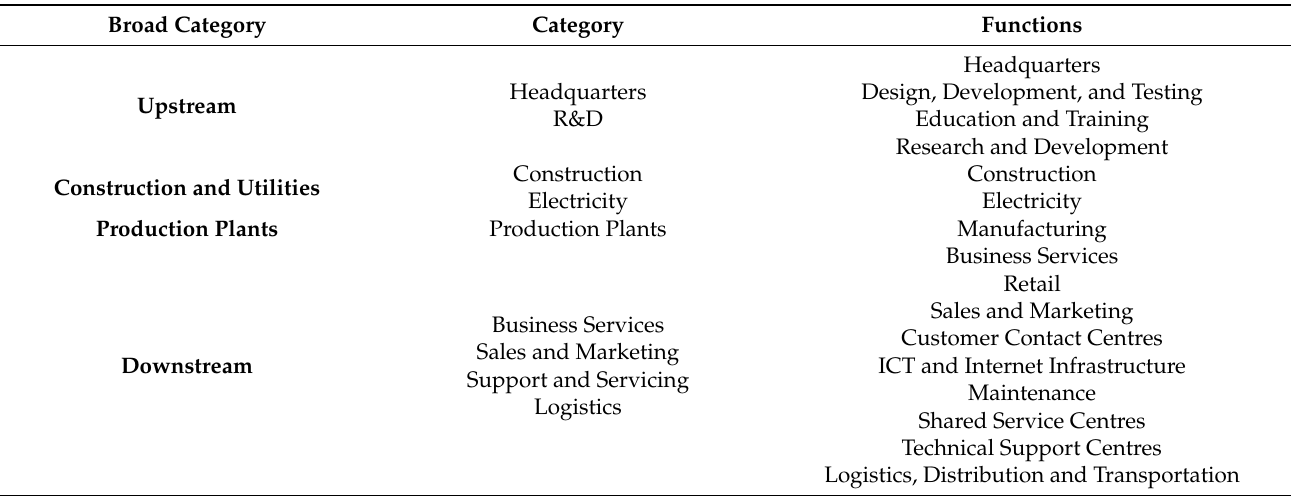
Table A1. Taxonomy of Investments by Broad Function.